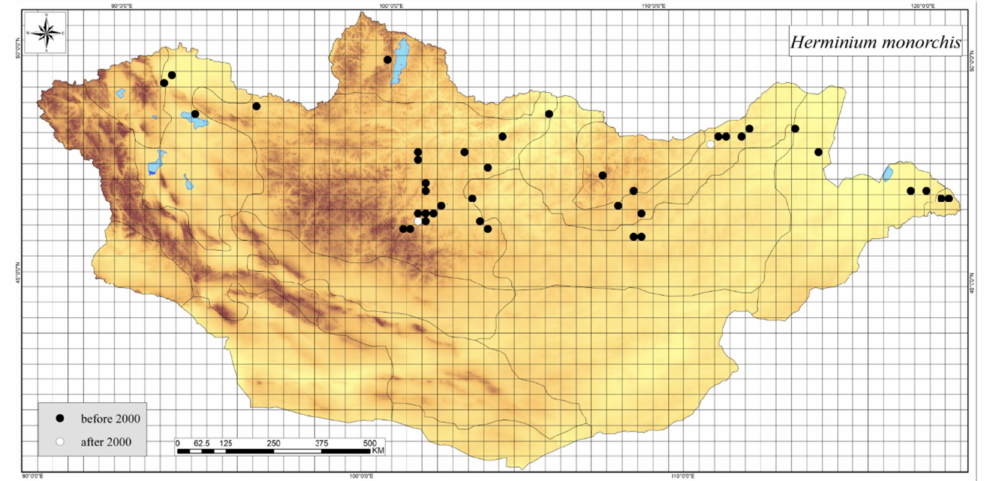
Figure A17. Distribution map of Herminium monorchis in